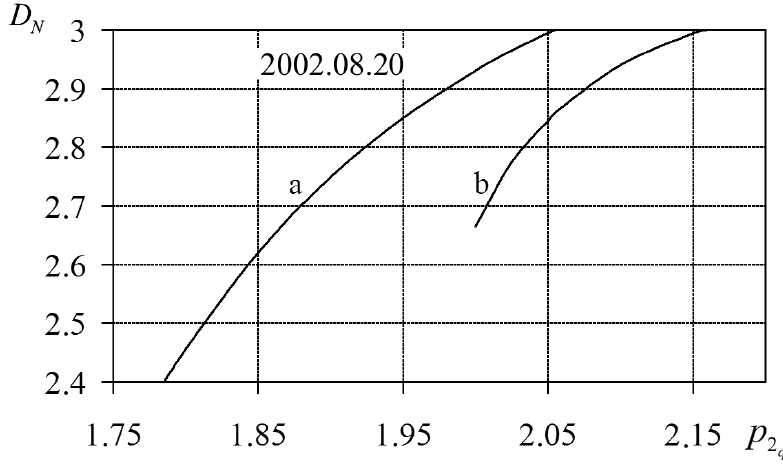
Fig. 1. Plots of the generalized multifractal spectrum D N ( p 2 of small-scale ionospheric turbulence.